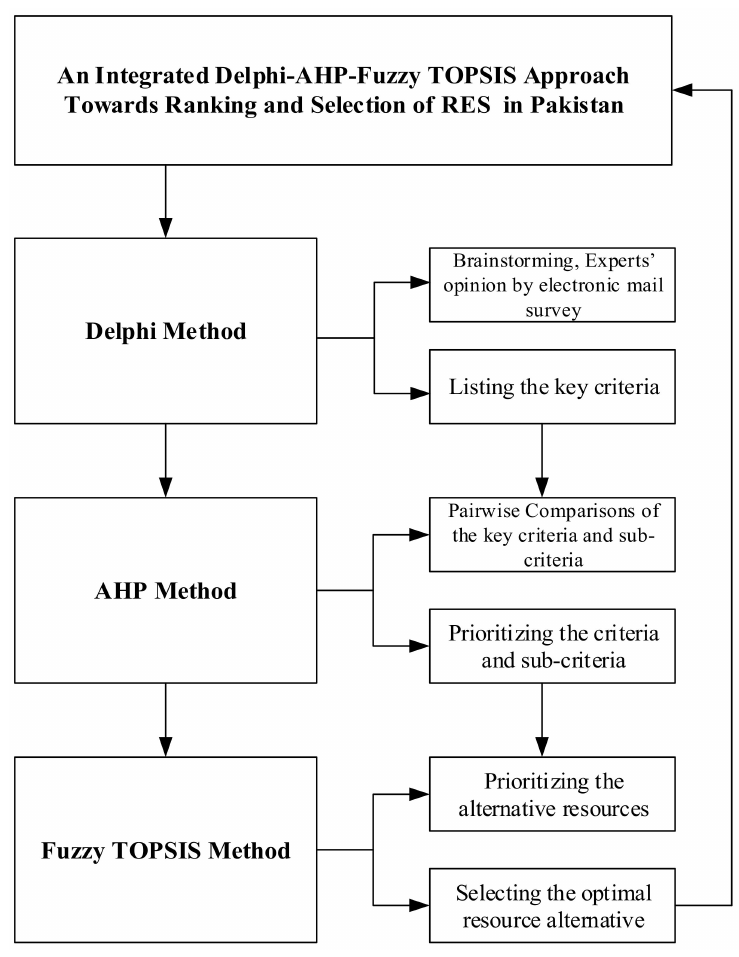
Figure 6. Decision model of the